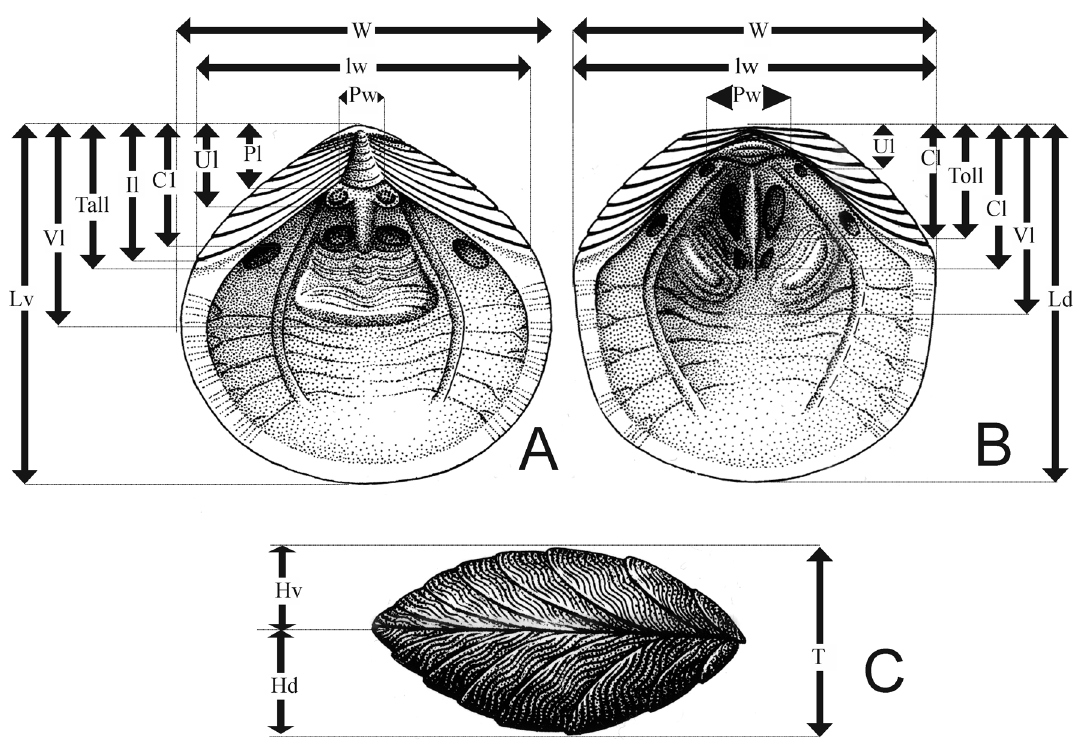
Fig. 7. Aulonotreta neptuni sp. nov., all from the lower Darriwilian Kunda Stage ( Asaphus raniceps Biozone), Öland. The recon- structions are based on multiple specimens, all drawn at approximately 2.5 times. A , reconstruction and interpretation of the ventral interior, with explanation of measurement; B , reconstruction and interpretation of the dorsal interior with explanation of measurement; C , reconstruction and interpretation of the profile of a complete articulated shell (based mainly on SGU9920; Fig. 6E).